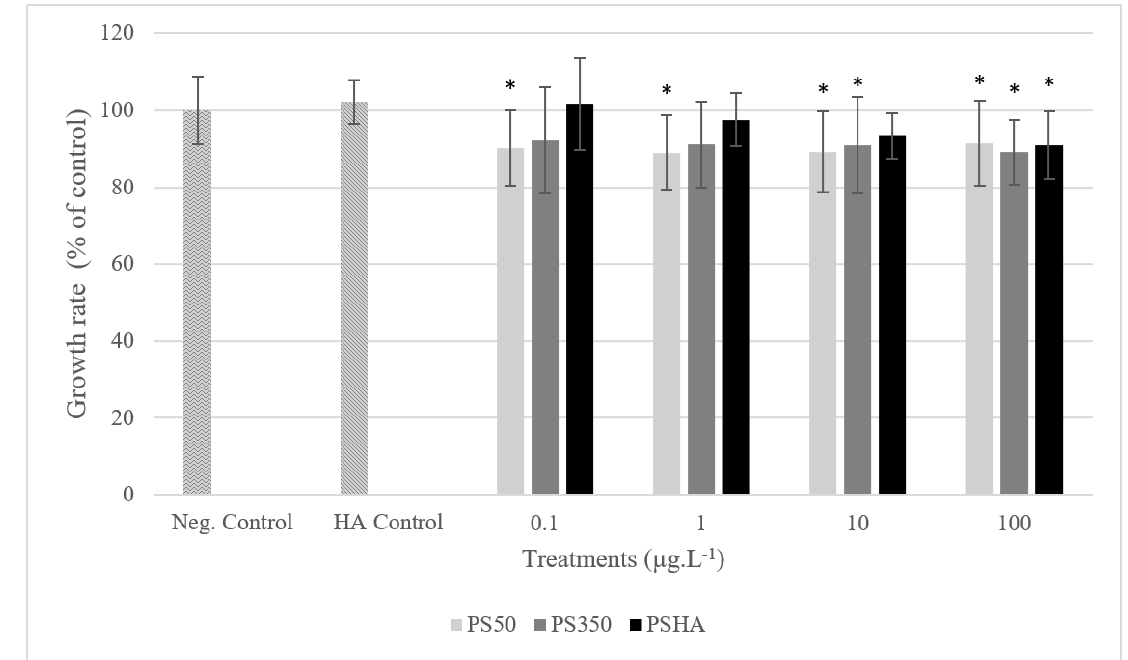
Figure 4. The growth rate of amphibian larvae exposed to PS50, PS350, and PSHA. Error bars show the standard deviation of mean values. *: significantly different from control (Kruskal–Wallis test, p < 0.05).